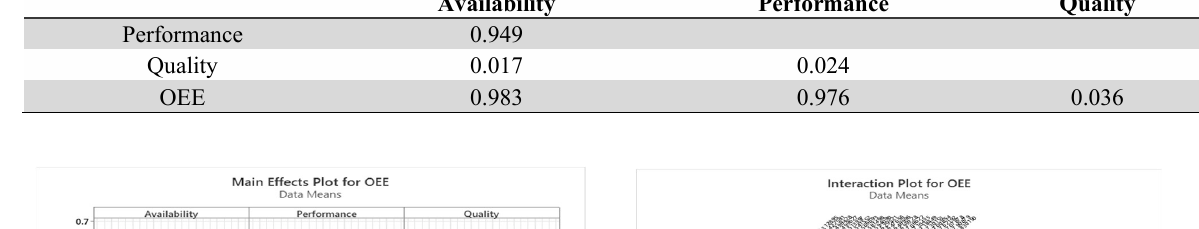
Pearson Correlation: Availability (%), Performance (%), Quality (%, OEE (%) Availability